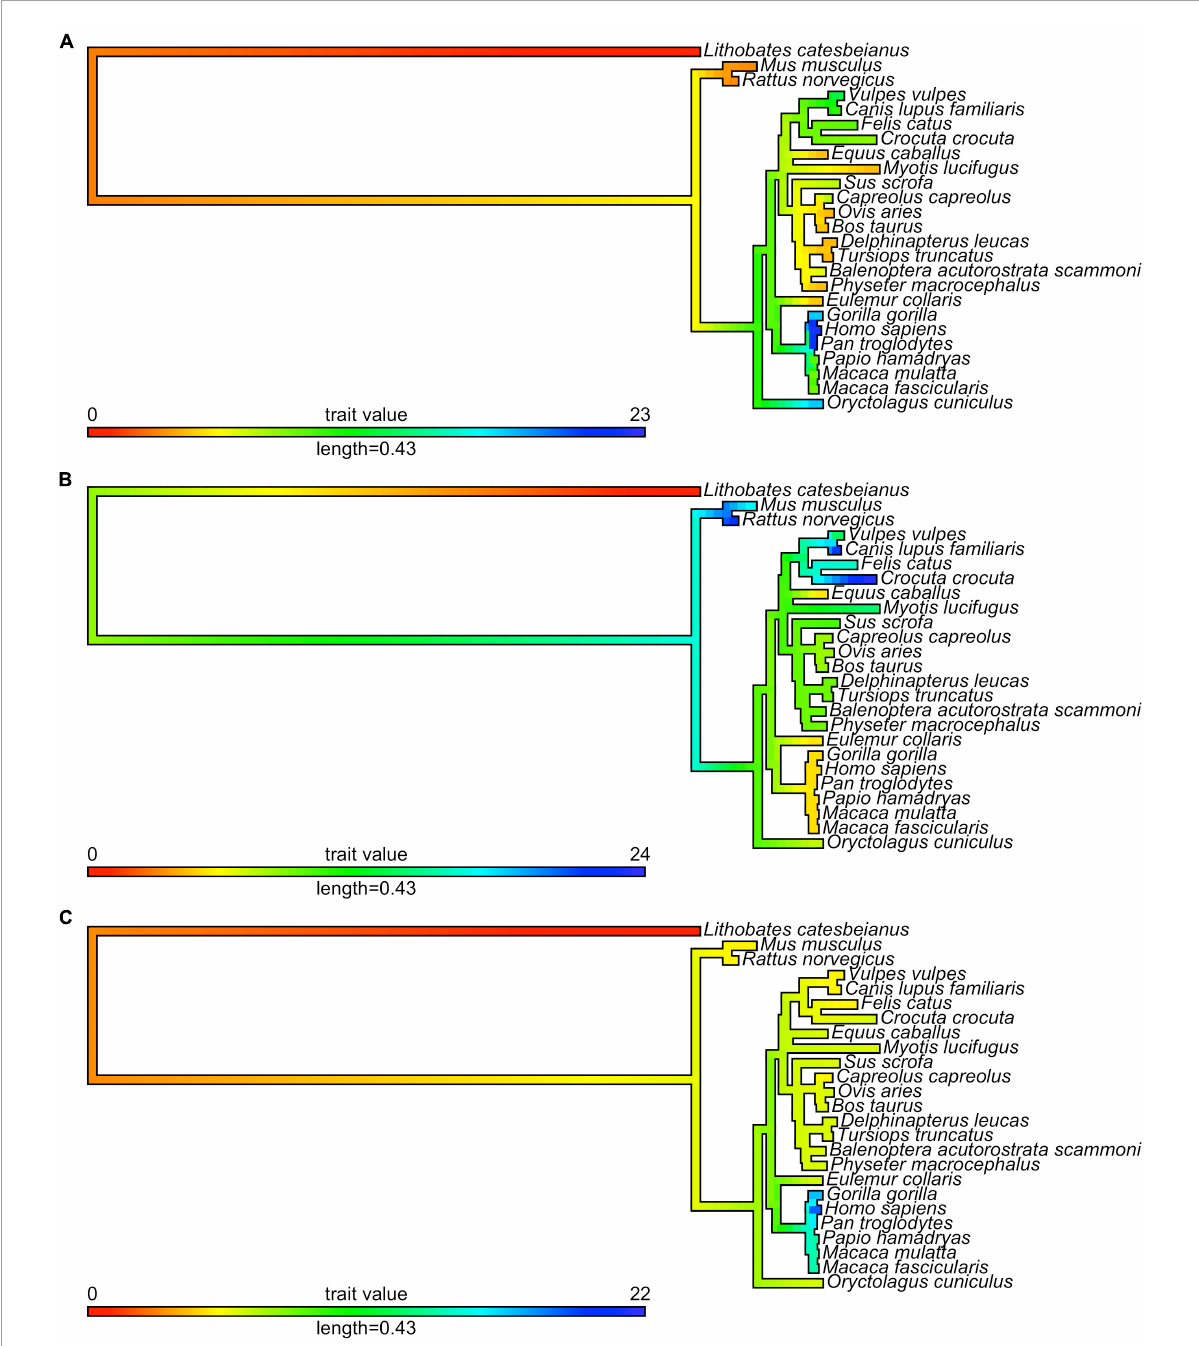
FIGURE3 Evolution of mono-amino acid repeat lengths in androgen receptor. The same ML tree as on Figure 2 (here shown as a phylogram) was colored according to the reconstructed length of polyQ1 (panel A ), polyQ2 (panel B ), and polyG (panel C ) repeats using the phytools R package (162) and its fastAnc and conMap